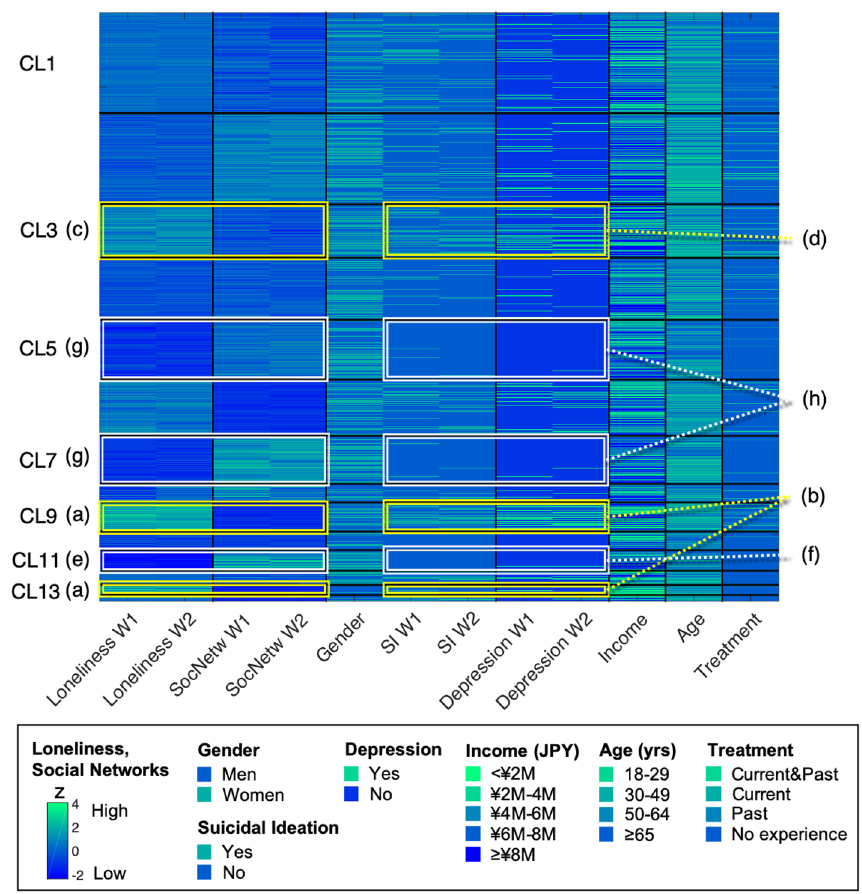
Figure 4. Visualization of an exhaustive interaction structure of factors associated with depression. The rows represent the data of the participants. The columns represent depression, suicidal ideation, and their associated factors. The black lines show the clusters of participants and factors, respectively. The colours in the cells indicate the magnitude of the z-values or the demographic attributes (see Box at the bottom of the figure). The appended (a), (c), (e), and (g) indicate clusters with significantly higher or lower loneliness and social networks, and (b), (d), (f), and (h) with significantly higher or lower depression and suicidal ideation. M, million; SI,